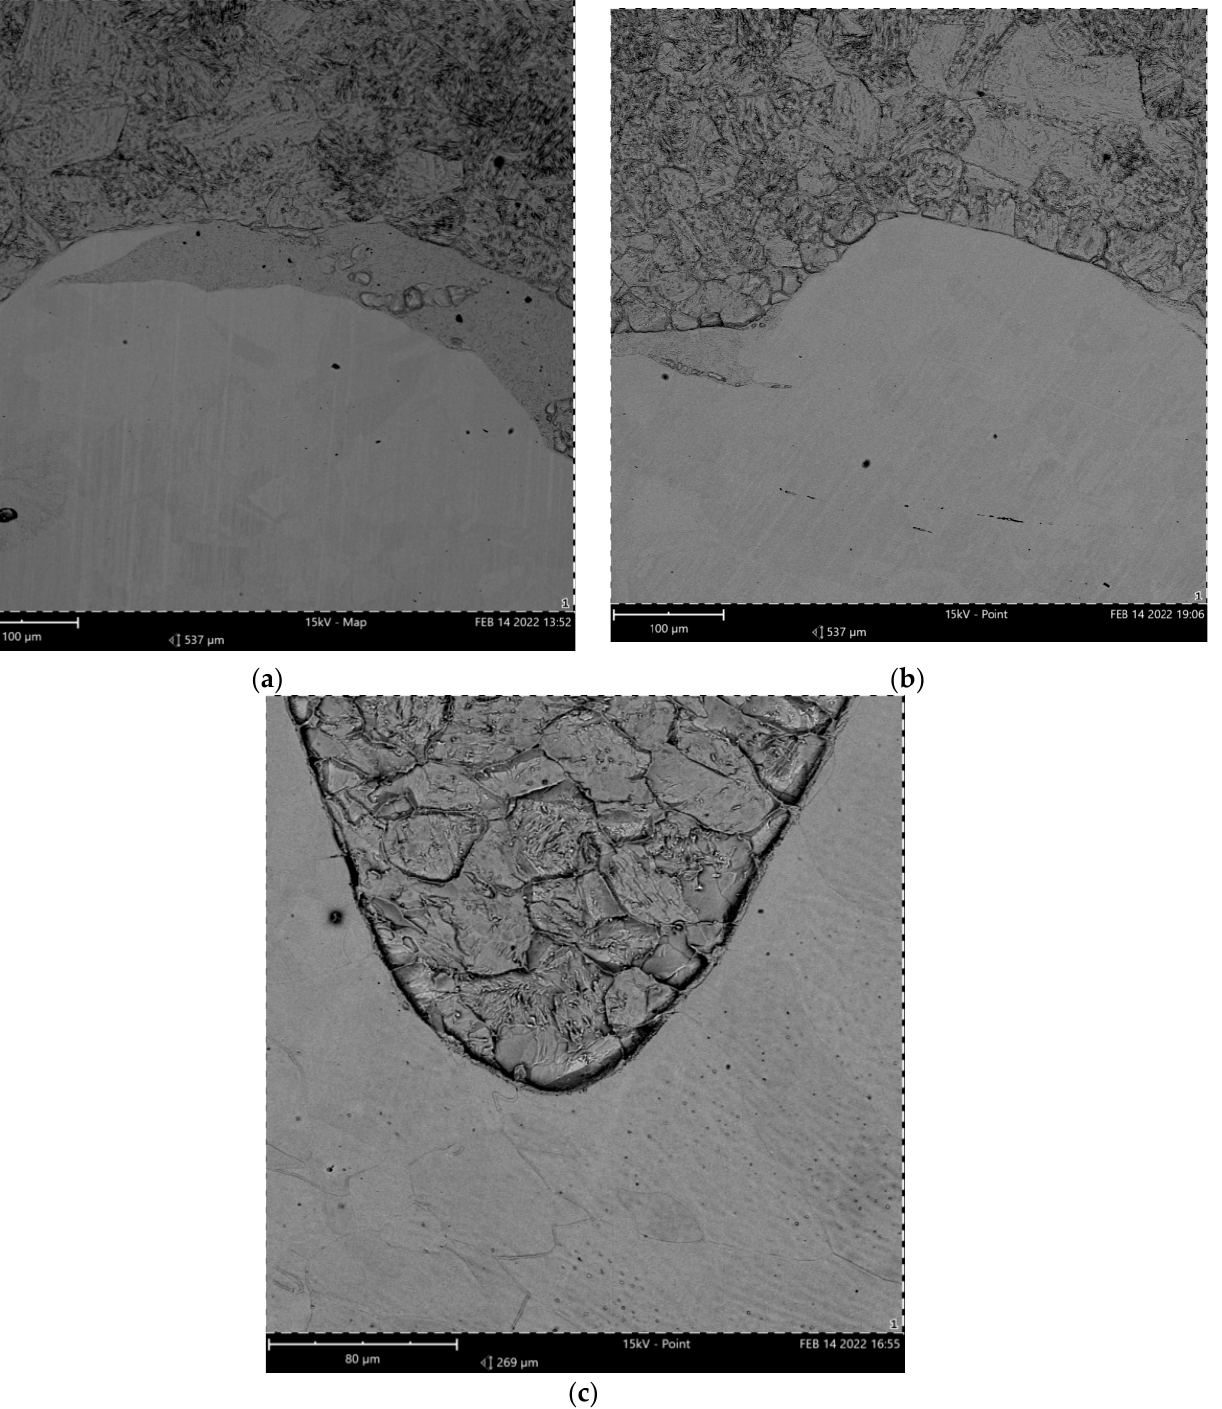
Figure 13. SEM microstructure of the joint area samples taken ( a ) after rolling for a v = 1.0, ( b ) after asymmetric rolling for a v = 0.75, and ( c ) after asymmetric rolling for a v = 0.8.